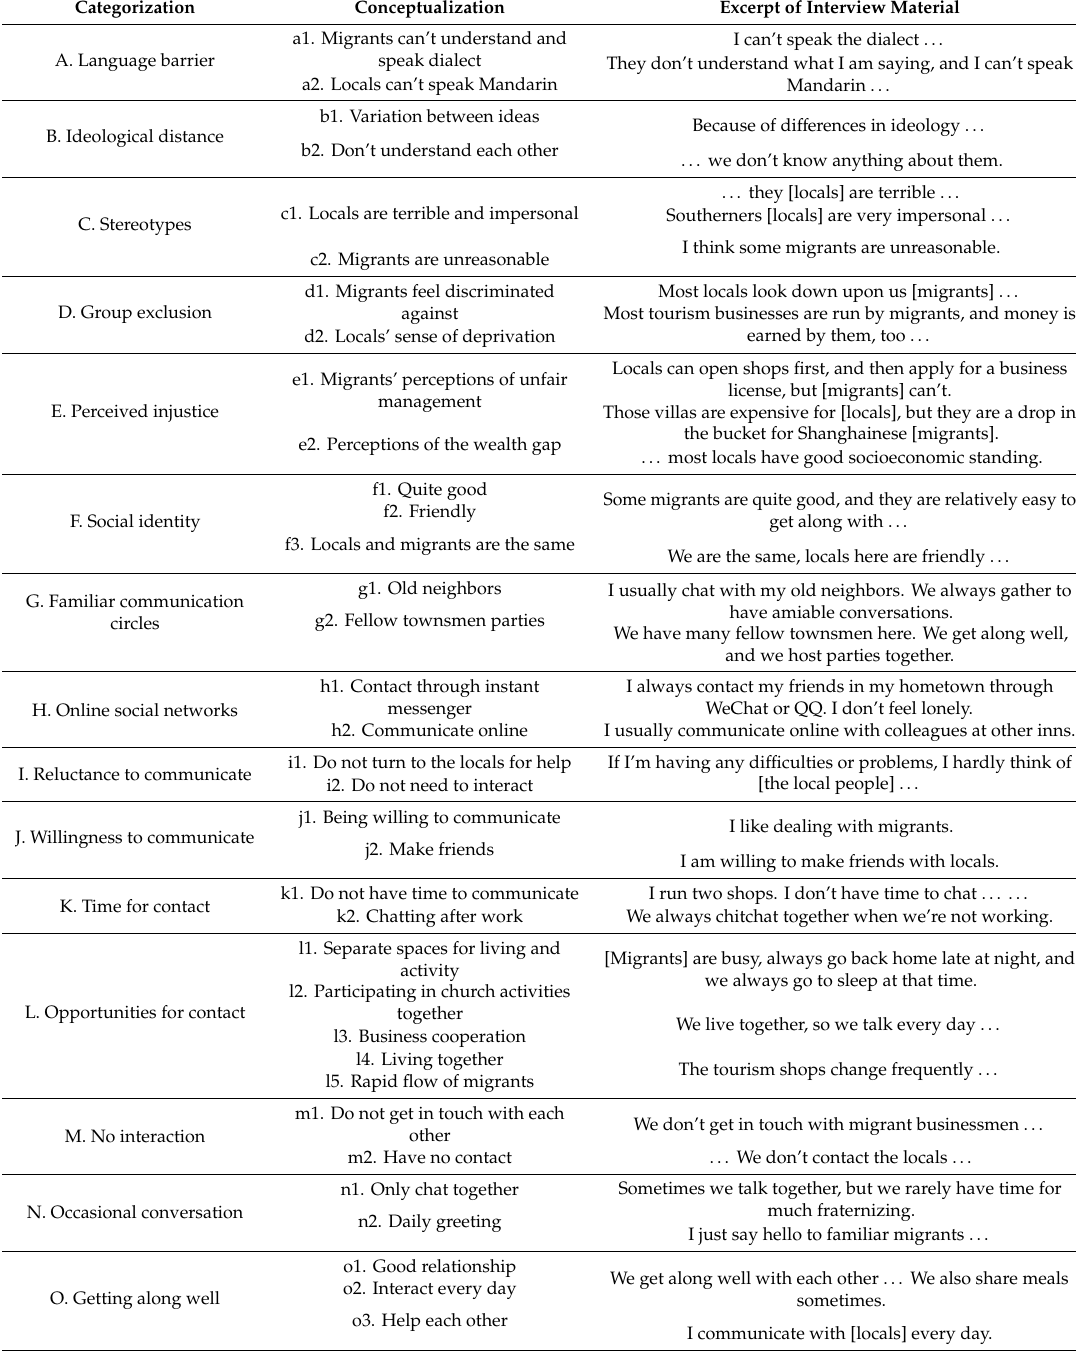
Table 2. Examples of open coding